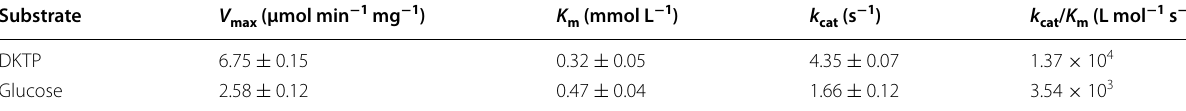
All reactions for the calculation of kinetic parameters were carried out in 0.1 mol L − 1 TEA buffer (pH 8.0) at 30 °C. For activity assay to calculate kinetic parameters, the cofactor of NADPH or NADP + was added in the reaction mixture at saturated concentration towards the enzyme. All the results were the average of three parallel